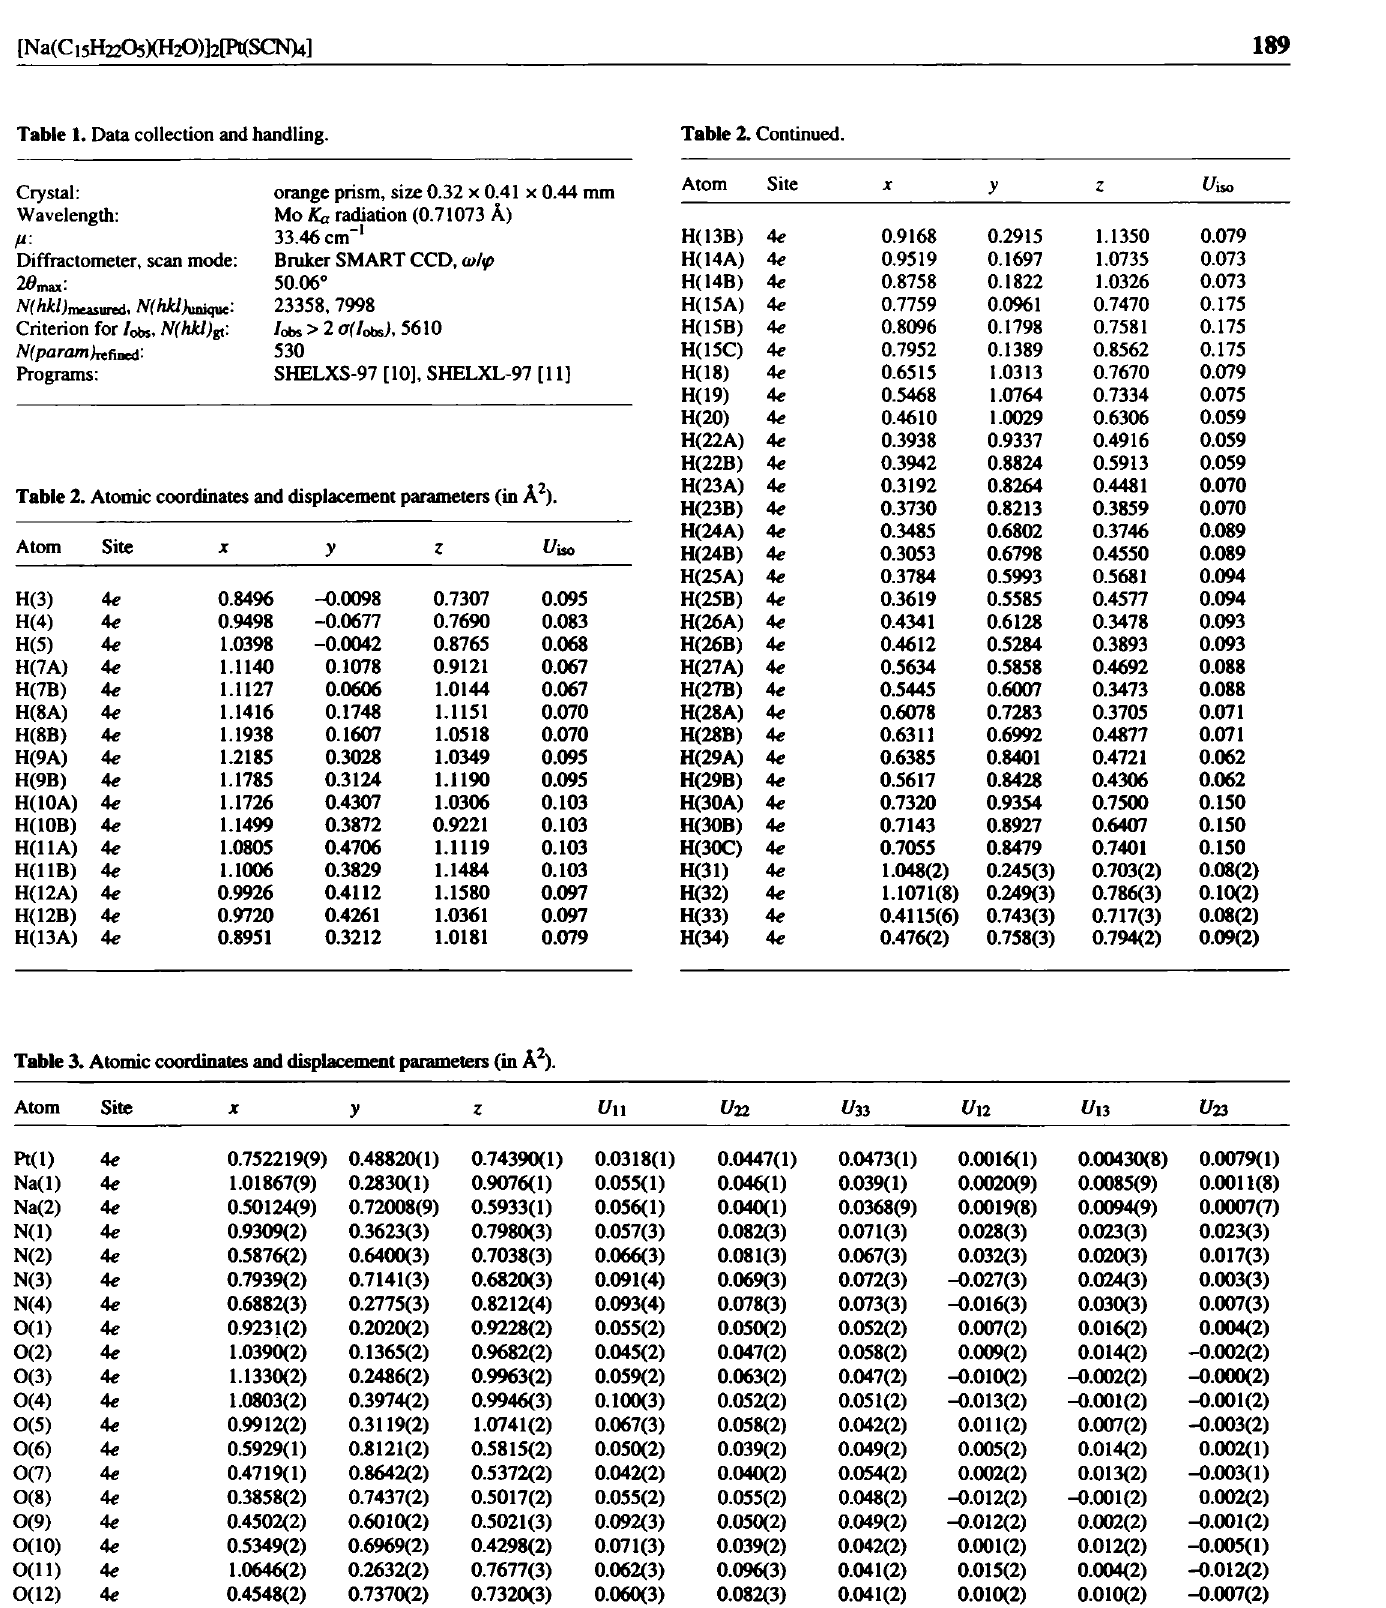
Table 1. Data collection and handling.